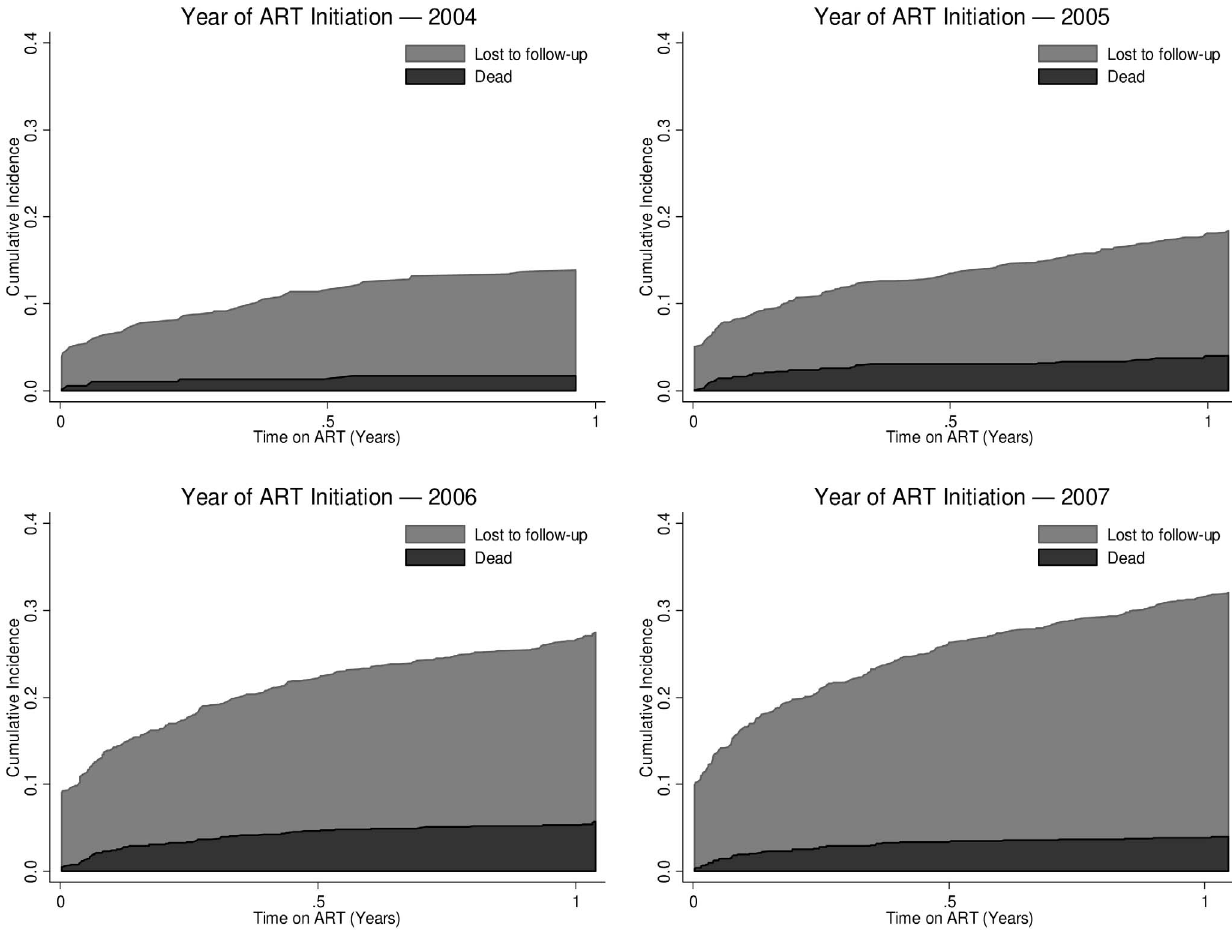
Figure 1. Cumulative Incidence of Mortality and Loss to Follow-up (LTFU) among Adults Enrolled in Coˆte d’Ivoire’s National ART Program during